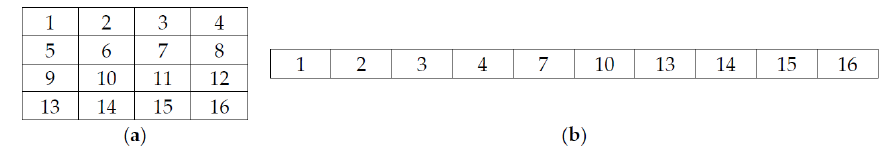
Figure 7. ( a ) Sample CFF matrix; ( b ) Z-Scanned one-dimensional